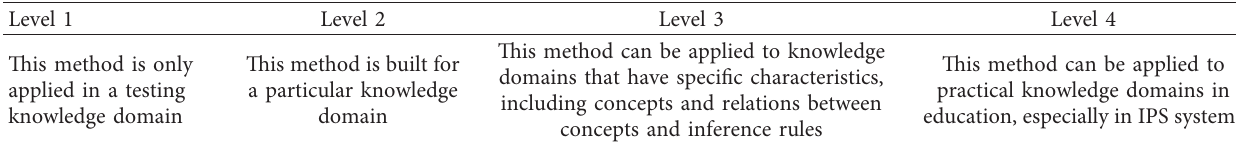
Table 2: Levels of the generality criterion.